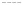
a. Regression models considering changes in children’s physical fitness (Léger test: A, B; Agility shuttle test: C, D; Long jump test: E, F) reported as a function of BMI category and age class. Girls: A, C, E; Boys: B, D, F. Underweight, ----; normal weight, ----; overweight, ----; and obese, ----. *Significantly different slope relative to that for normal weight children (p<0.05). b. Regression models considering changes in children’s physical fitness (frontal throw test: G, H; Sit & Reach test: I, J; standing balance test: K, L) reported as a function of BMI category and age class. Girls: G, I, K; Boys: H, J, L. Underweight, ----; normal weight, ----; overweight, ----; and obese, ----. *Significantly different slope relative to that for normal-weight children (p<0.05).